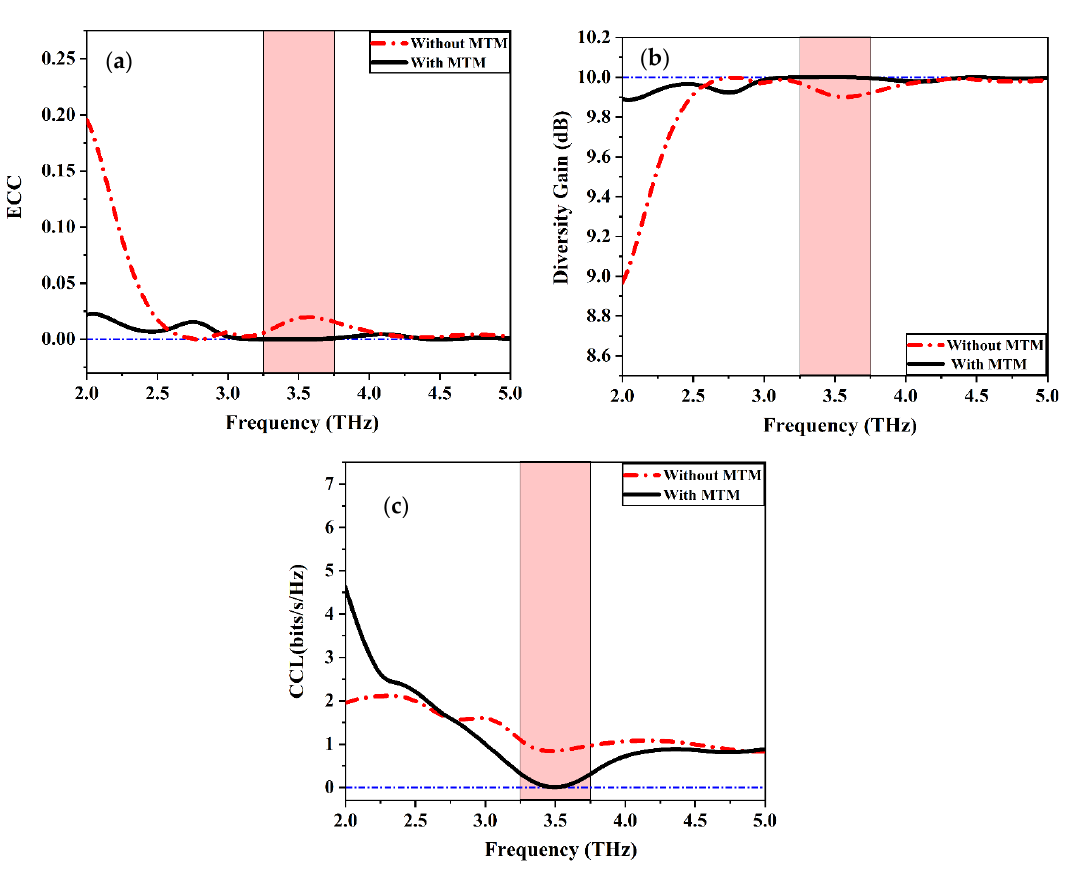
Figure 21. ( a ) Envelop correlation coefficient (ECC), ( b ) Diversity gain (DG), and ( c ) channel capacity loss (CCL) of Ant. C with and without the presence of the MTM unit cell .